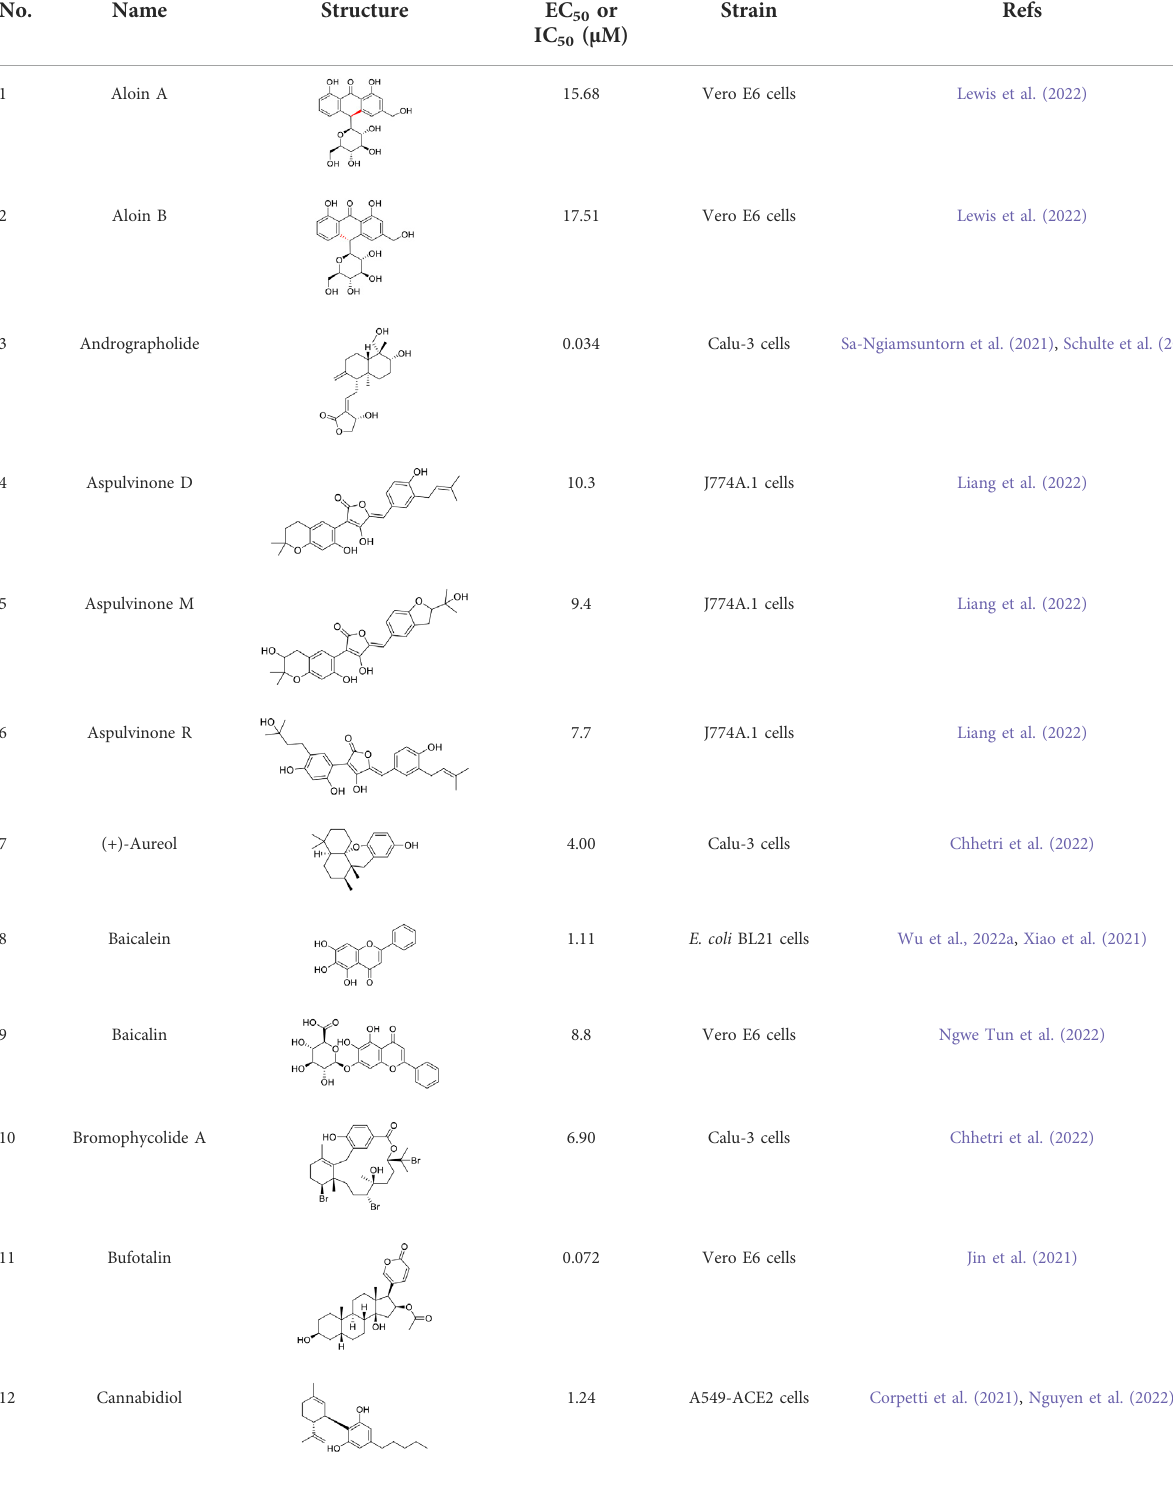
TABLE 1 Other promising natural products for treating SARS-CoV-2 infection in vitro .